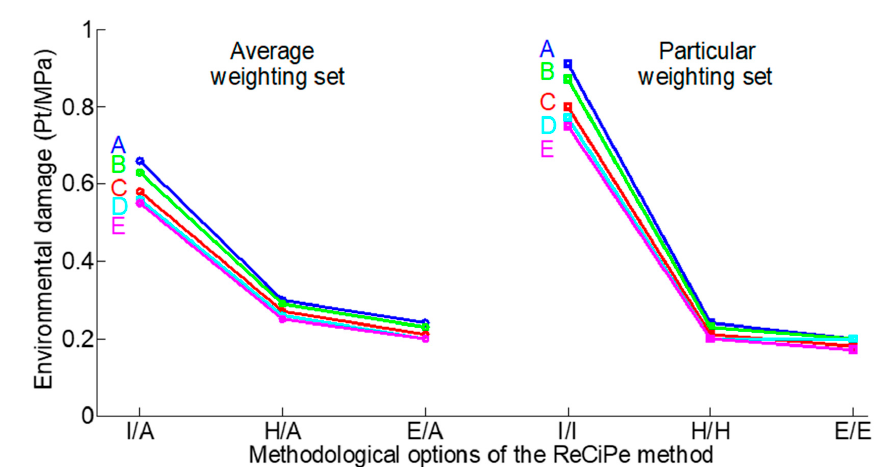
Figure 4. Environmental damage caused by replacing sand with coal bottom ash (CBA): A—CBA0, B—CBA25, C—CBA50, D—CBA75, and E—CBA100. The life-cycle assessments (LCAs) were